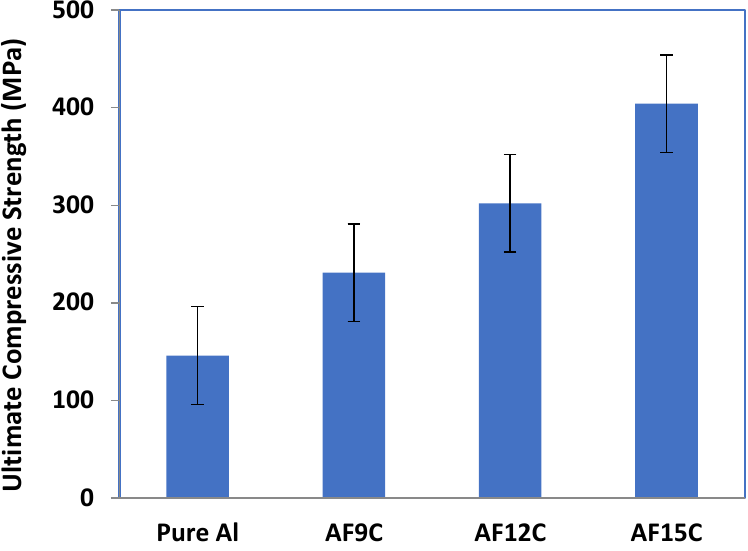
Figure 9. Variation in compressive strength of the aluminum nanocomposite.